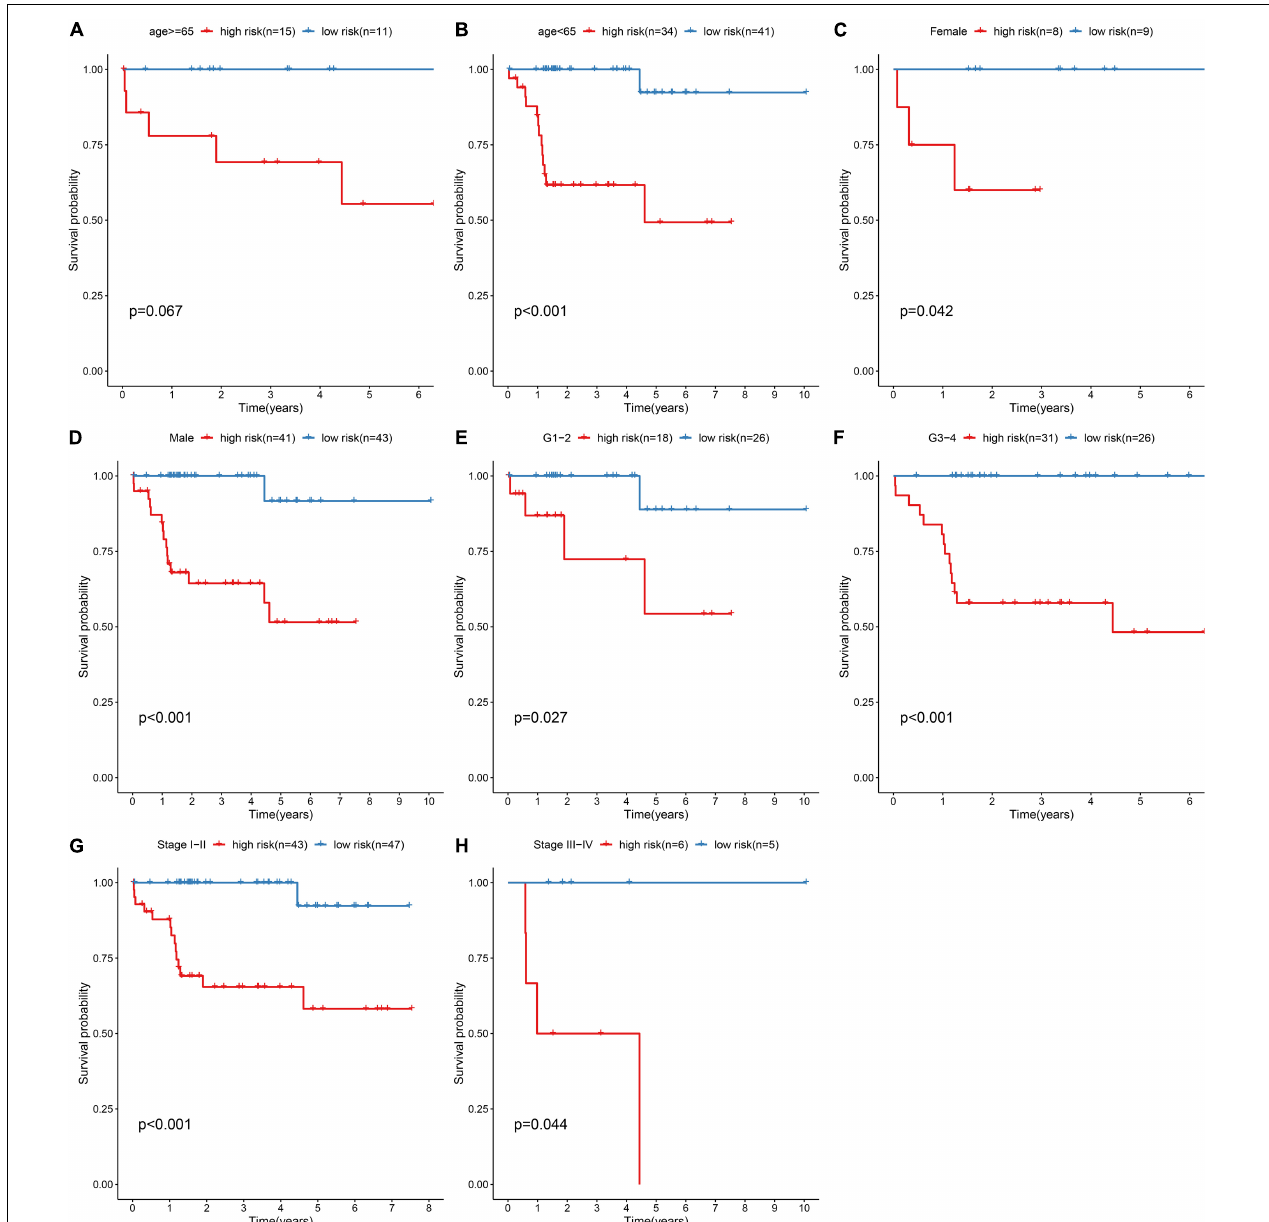
FIGURE 4 | Subgroup analysis for assessing the sensibility of the risk score to predict HBV-related HCC patients’ prognosis. Kaplan-Meier curves for survival outcomes of high- and low-risk patients in (A) age ≥ 65 and (B) < 65 subgroups, (C) female and (D) male subgroups, (E) grade 1–2 (G1-2) and (F) grade 3–4 (G3-4) subgroups, (G) stage I–II and (H) stage III–IV subgroups. P values were estimated with log-rank tests.